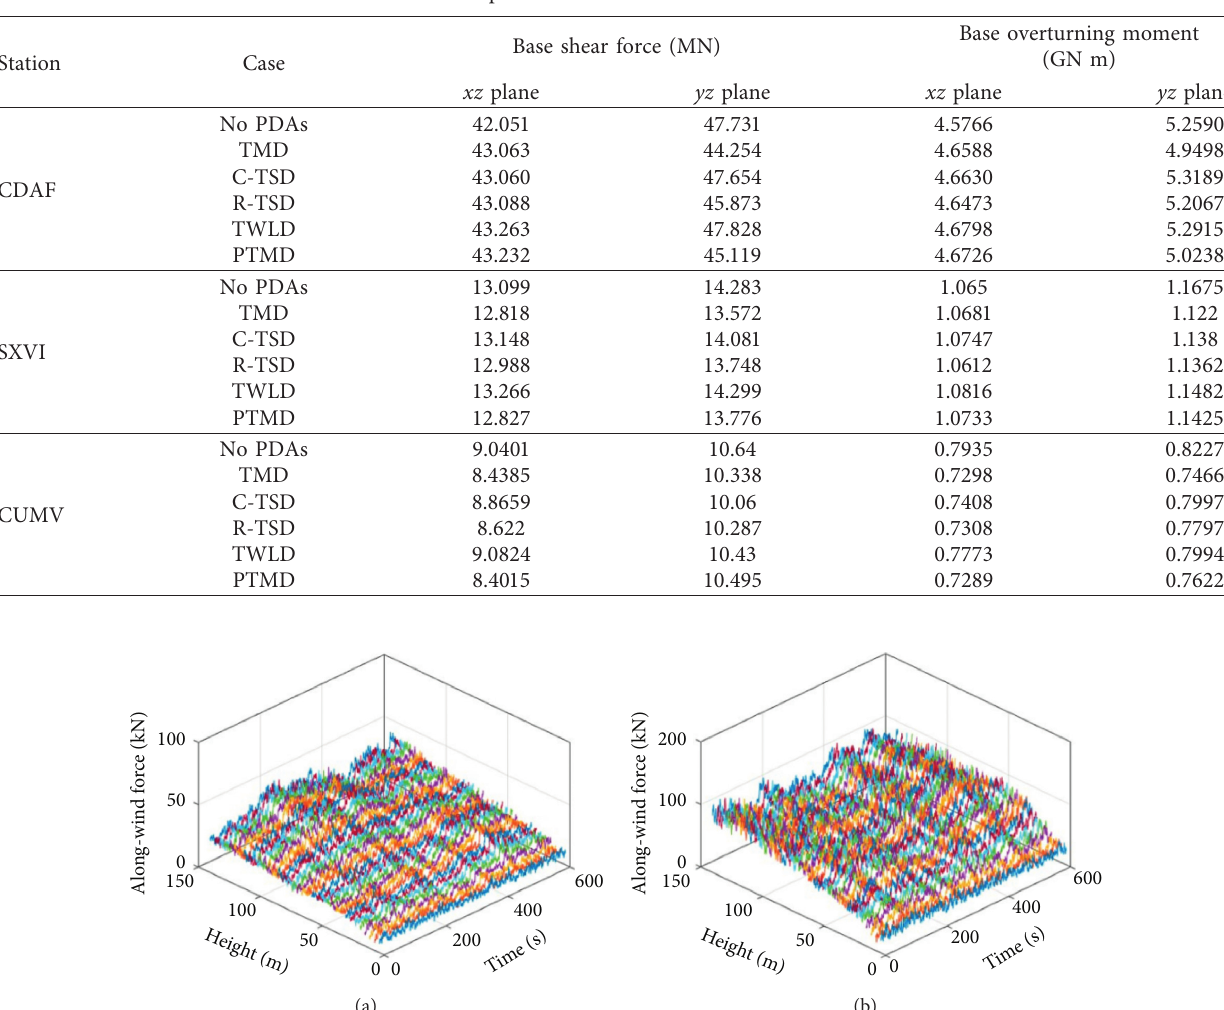
Table 19: Seismic peak values for the internal forces at the base.